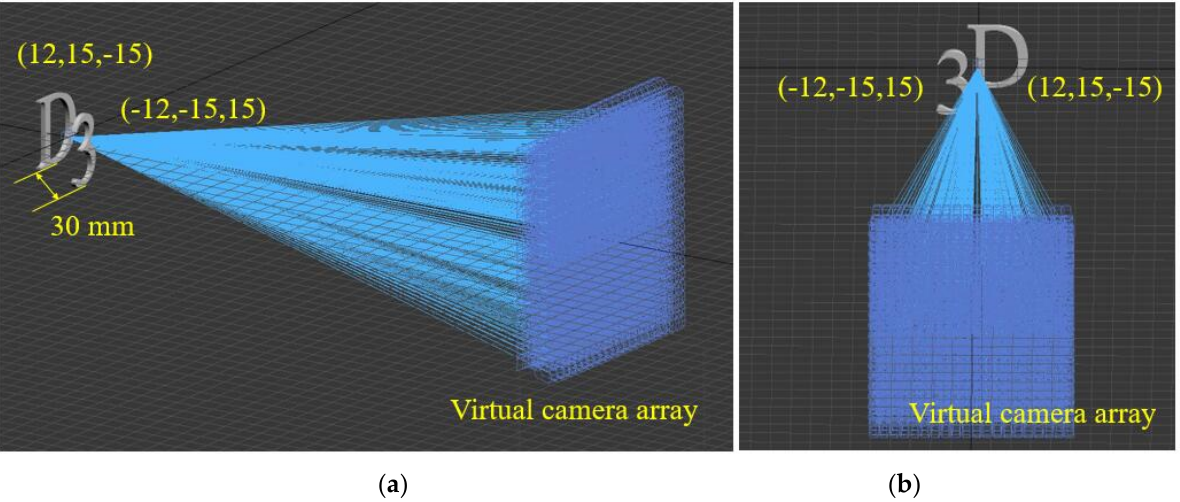
Figure 8. Schematic diagram of EIA acquisition: ( a ) side view and ( b ) top plan view.